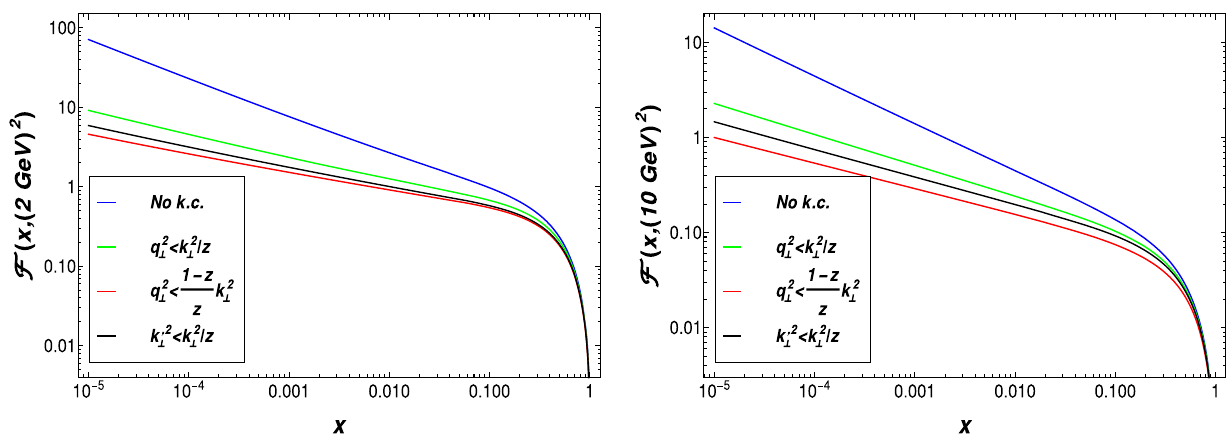
Fig. 5 Solutions to the BFKL equation with three different forms of the constraint as a function of x for constant ¯ α S = 0 . 2. Left plot: k T = 2GeV, right plot k T =